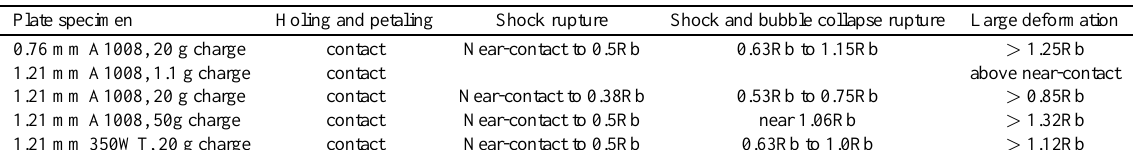
Table 3 Failure standoff regimes